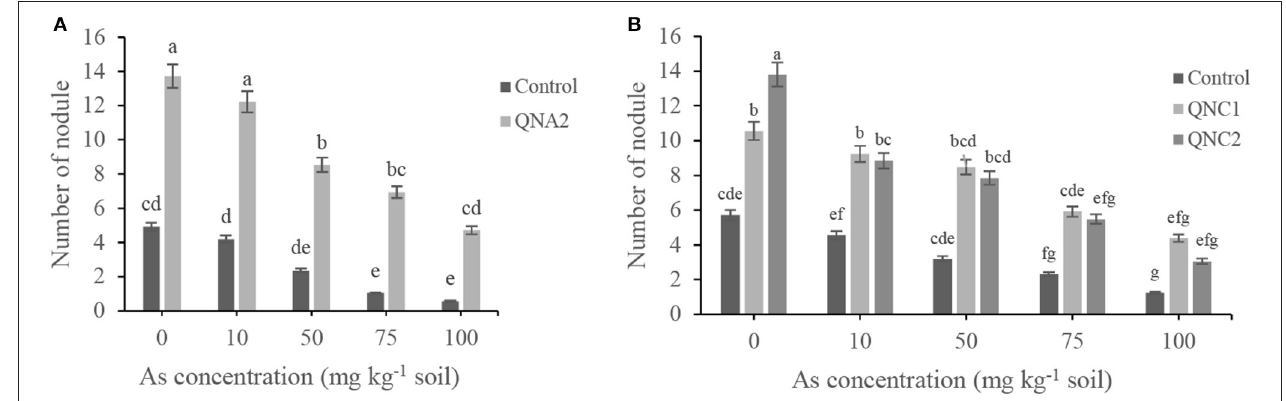
FIGURE 3 | Effect of different sodium arsenate concentrations on root nodule production of (A) alfalfa plants treated with Acinetobacter sp. QNA2, (B) chickpea plants treated with Pseudomonas sp. QNC1 and Rahnella sp. QNC2. Data are the mean of three individual repetitions. Error bars indicate a standard error, and different letters above error bars represent significant differences based on a least significant difference (LSD) test ( P = 0.05).